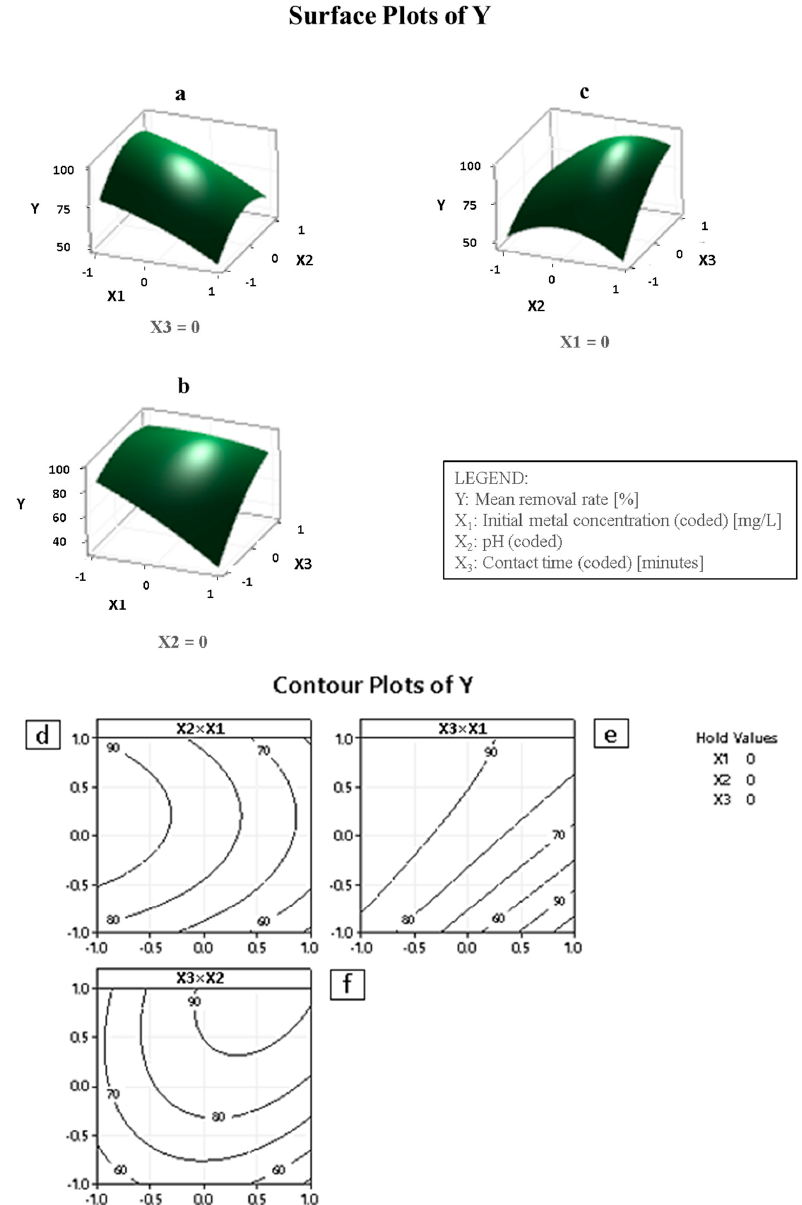
Figure 6. Response surfaces and contour plots for the removal of Cd 2+ using CS-KAC-Ag. ( a , d ) Effects of Cd 2+ concentration and pH on % removal; ( b , e ) Effects of Cd 2+ concentration and contact time on % removal; ( c , f ) Effects of pH and contact time on % removal.